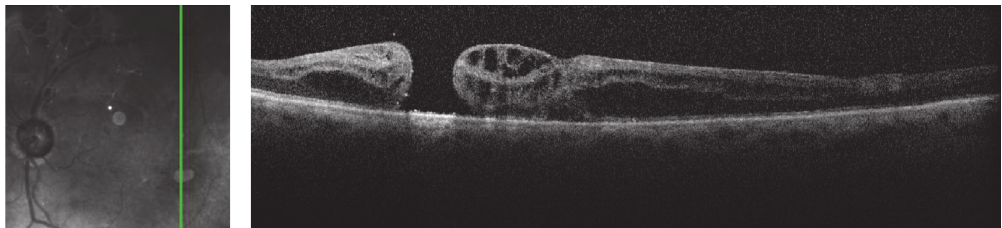
Figure 1: OCT taken after implant insertion showing inferotemporal eccentric macular hole.